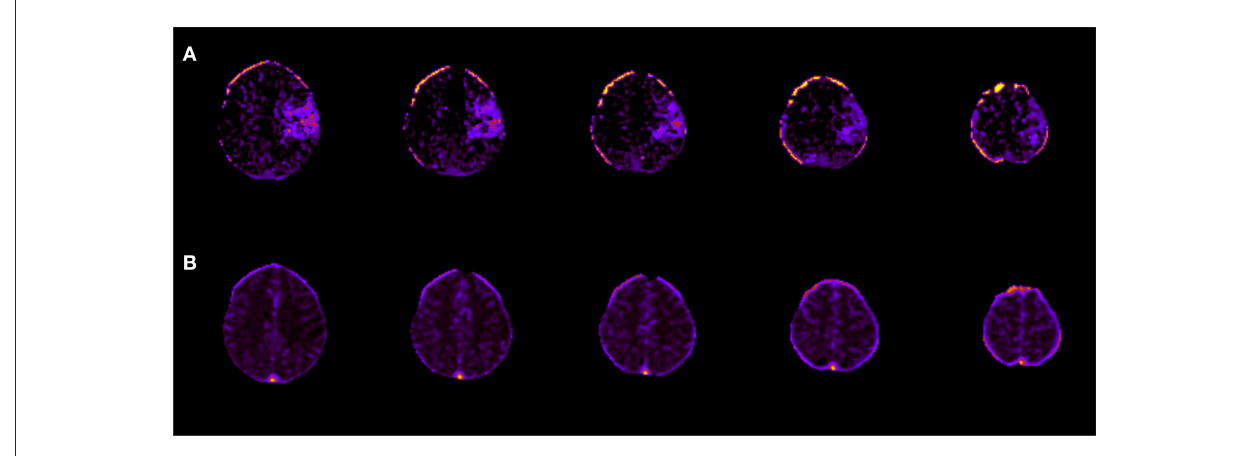
FIGURE3 Skull artifacts. For subject 3, skull artifacts can be seen in their (A) Delay time and (B) CBF maps near the top of the skull.